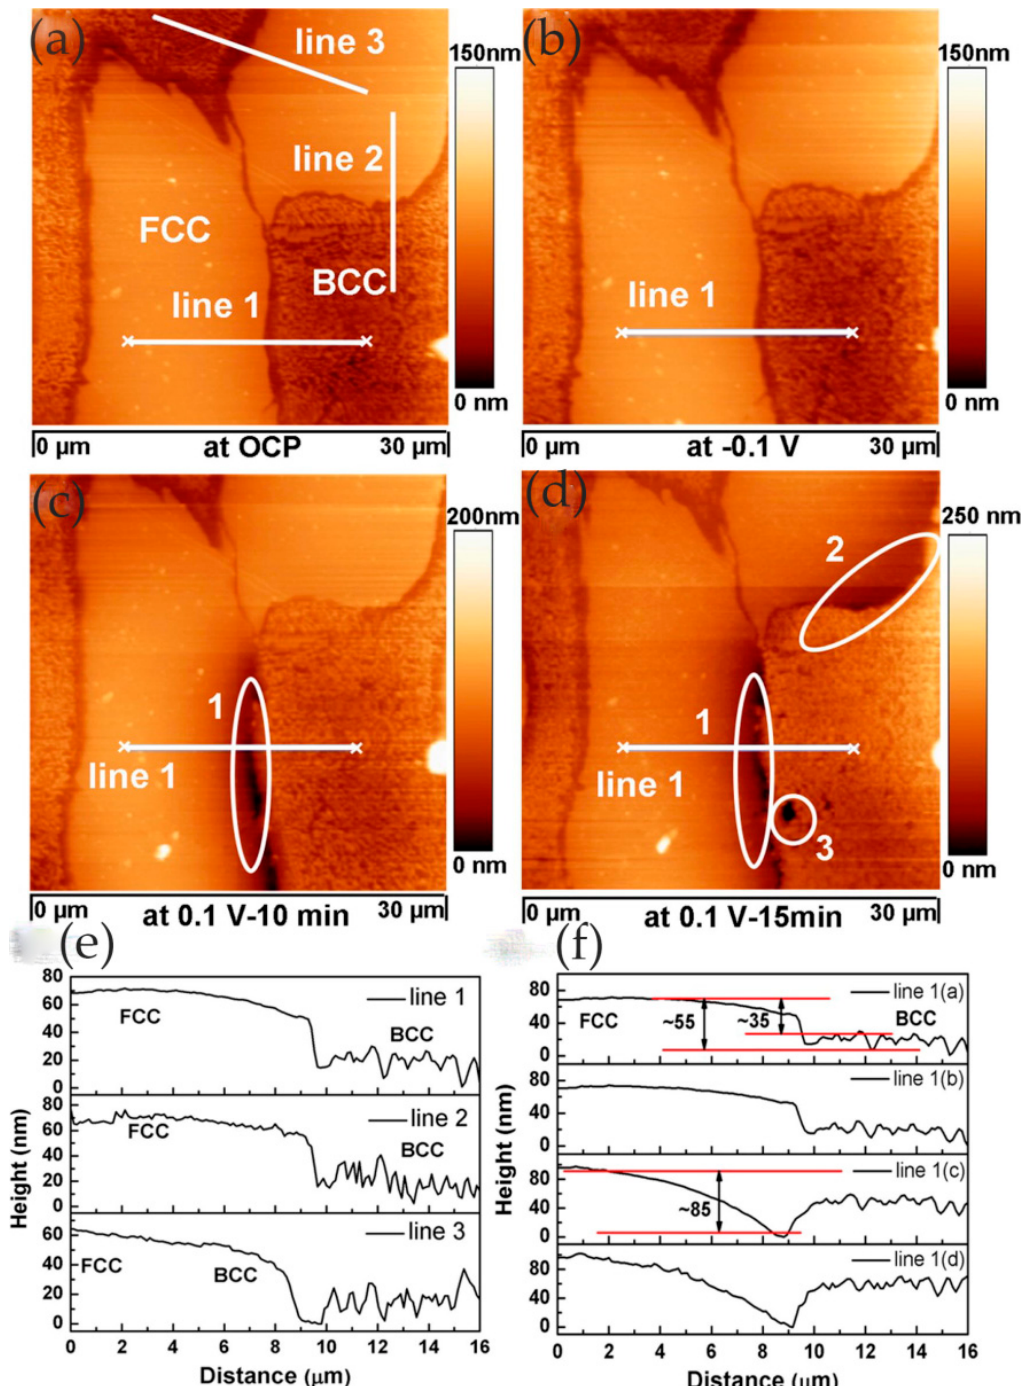
Figure 27. In situ EC-AFM topography images of the Al 0.7 CoCrFeNi HEA after 10 min of exposure in a 3.5 wt% NaCl solution at ( a ) OCP, ( b ) 0.1 V, and ( c ) 0.1 V, and ( d ) after 15 min of exposure at 0.1 V vs. SCE. ( e ) Three-line profiles across the phase boundaries illustrated in ( a ). ( f ) Vertical profiles along line 1 of the surface in ( a – d ). Reprinted with permission from Reference [63]; copyright 2018 Elsevier Ltd.